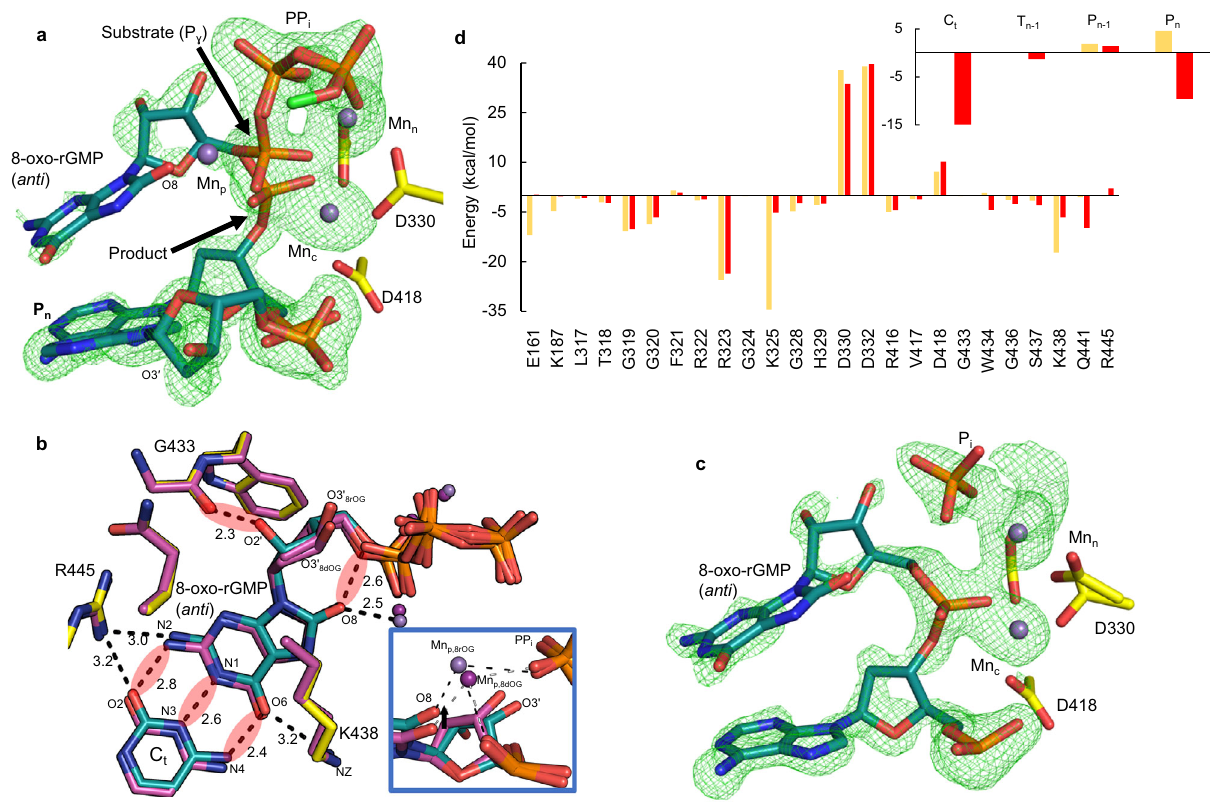
Fig. 3 8-oxo-rGTP(anti) insertion opposite cytosine. a Active site of the reaction state ternary complex of the 8-oxo-rGTP(anti):C t insertion after an overnight soak (960 min) in a Mn 2 + -containing cryo-solution. Arrows indicate bond broken (substrate) and formed (product). Protein sidechains are shown in yellow stick representation, nucleotide in green and DNA in cyan. Mn 2 + is shown as a magenta sphere. Simulated annealing (F o – F c ) omit density (green mesh) is shown at 3 σ . b Top down close up view of nucleotide and possible product metal (Mn p,8rOG , purple sphere) interactions in the ribo-8-oxo- GMP(anti)/GTP:C t active site. Shown is an overlay with the deoxy-8-oxo-GTP(anti)/GMP(anti):C t Mn 2 + -reaction state ternary complex in magenta. The product metal in the latter structure (Mn p,8dOG ) is shown as a magenta sphere. Mn p,8rOG bridges O8, an oxygen of the phosphate of the incorporated nucleotide and an oxygen of PP i . Hydrogen bonding and other key distances (Å) are shown with black dashes. Red spheres indicate (unfavorable) destabilizing interactions. Inset. Comparison of Mn p,8rOG and Mn p,8dOG coordination of O8 and product phosphate oxygens. A black arrow indicates differences in the position of O8. c Mn 2 + -product complex of the 8-oxo-rGTP(anti):C t insertion. Simulated annealing omit density is shown as a green mesh contoured at 3 σ . d Contributions of selected protein and nucleic acid residues to the interaction free energy of 8-oxo-rGTP in the unreactive (light orange) and reacted (red) conformations within the Mn 2 + -reaction state ternary complex of the 8-oxo-rGTP:C t insertion (see Supplementary Tables 6, 7). C t (template nucleotide), T n-1 (opposite P n-1 in template strand), P n-1 (primer strand), and P n (primer terminal nucleotide) represent selected nucleotides in the template or primer